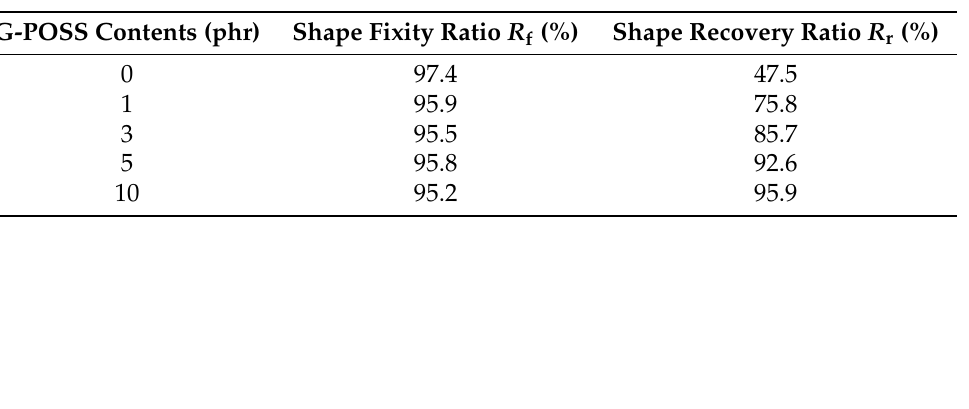
Table 3. Shape memory properties of PA12/POE/G-POSS blend with different POSS